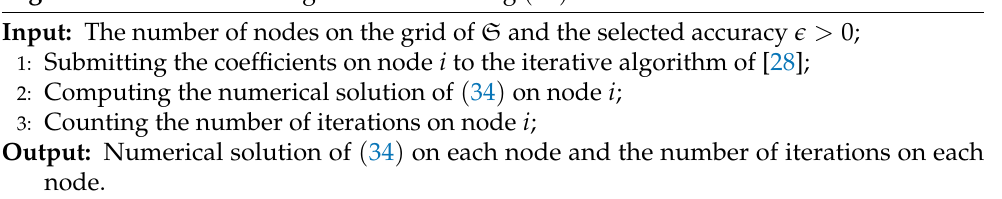
Algorithm 1 : Numerical algorithm for solving ( 34